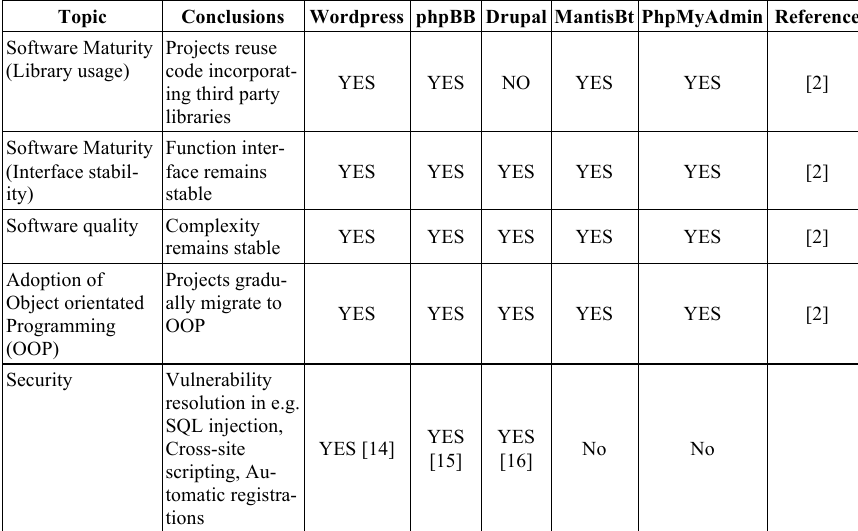
Table 1. Overview of reviewed